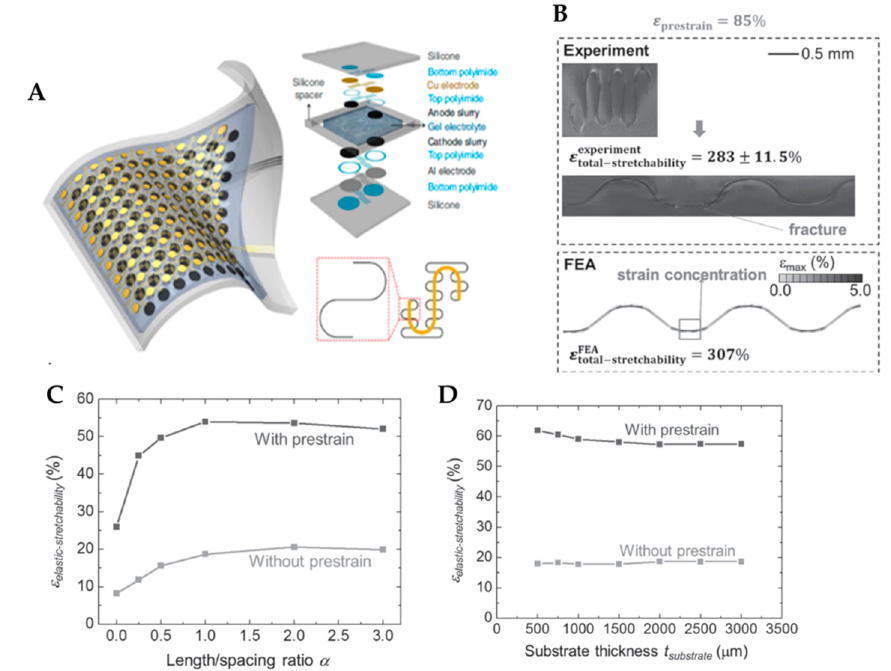
Figure 7. ( A ) Schematic illustration of a completed device, in a state of stretching and bending. Adapted with permission from [64]. Copyright (2013) Macmillan. ( B ) Experimental image of the serpentine interconnect and the fracture sites due to cyclic stretching (with an amplitude of 185%), and FEA results for the strain distribution when stretched to the predicted elastic stretchability (189%), for the case of 85% prestrain. Adapted with permission from [98]. Copyright (2013) WILEY-VCH Verlag GmbH and Co. KGaA, Weinheim . The influences of geometric parameters (( C ) for the length / spacing ratio, ( D ) for substrate thickness) on the elastic stretchability of serpentine interconnects with and without prestrain. Adapted with permission from [98]. Copyright (2013) WILEY-VCH Verlag GmbH and Co. KGaA, Weinheim.